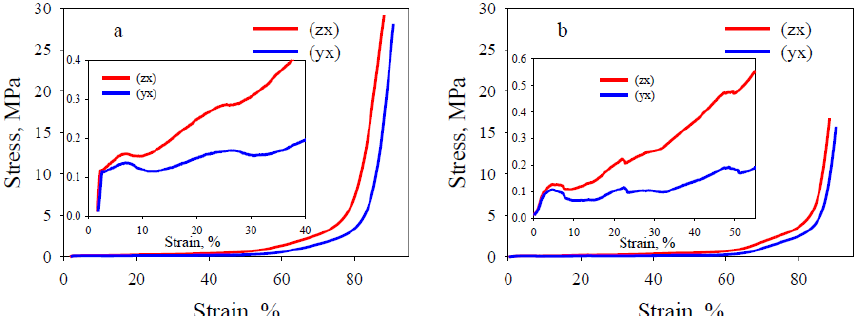
Figure 5. Representative stress–strain curves of lattice flexible TPU under compression. ( a )–honeycomb, ( b )–gyroid architecture. The inset shows the enlarged initial part of the same curves. Table 3. Mechanical properties of lattice flexible TPU. Compression test. Internal Architecture